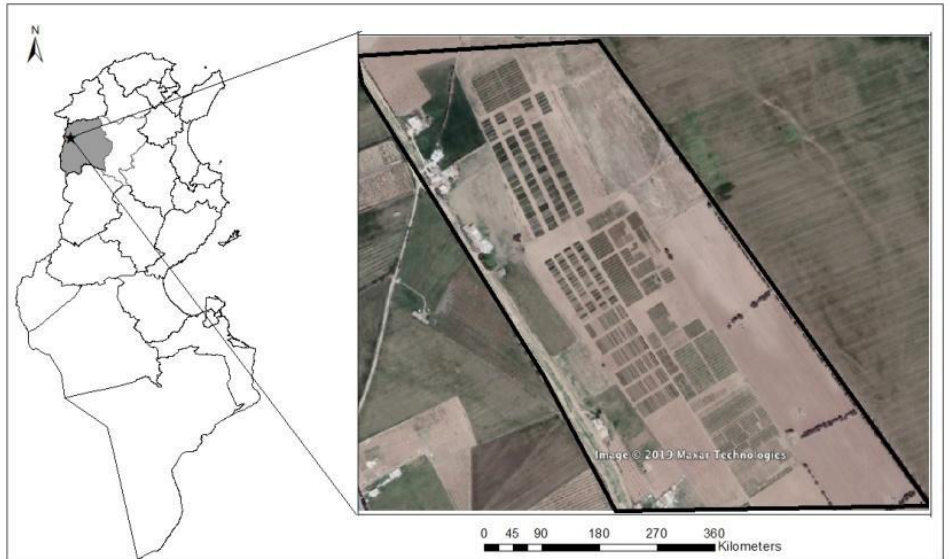
Figure 1. Location of the experimental site at the INRAT–Agricultural Experimentation Unit of kef .